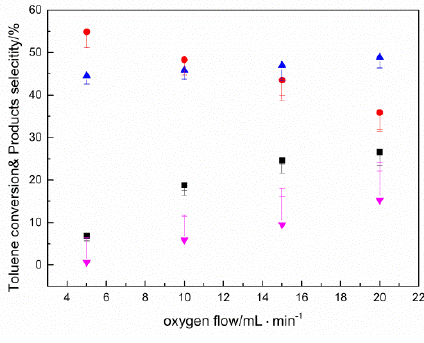
Figure 7. Catalytic performance for the selective oxidation of toluene on the Mn 3 O 4 / CNTs-3 with different oxygen flow rates.